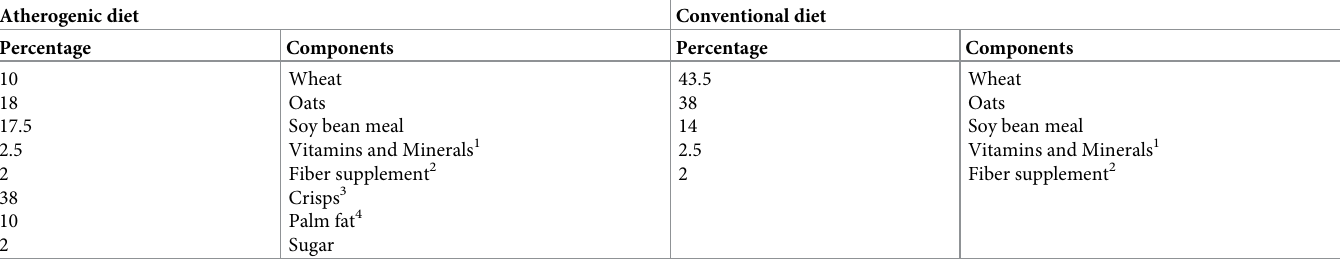
Table 1. Composition of atherogenic and conventional experimental